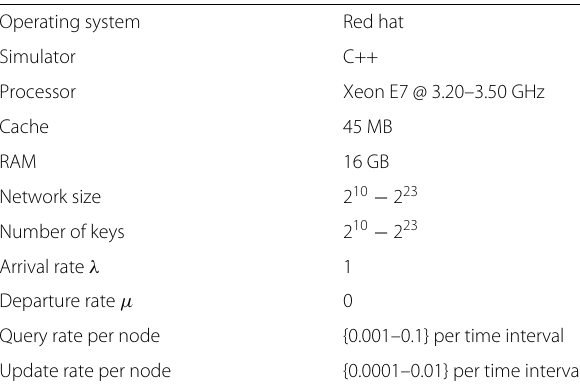
Table 3 Simulation parameters